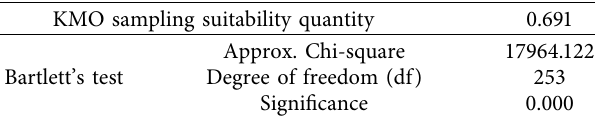
Table 4: KMO and Bartlett’s test of sphericity.